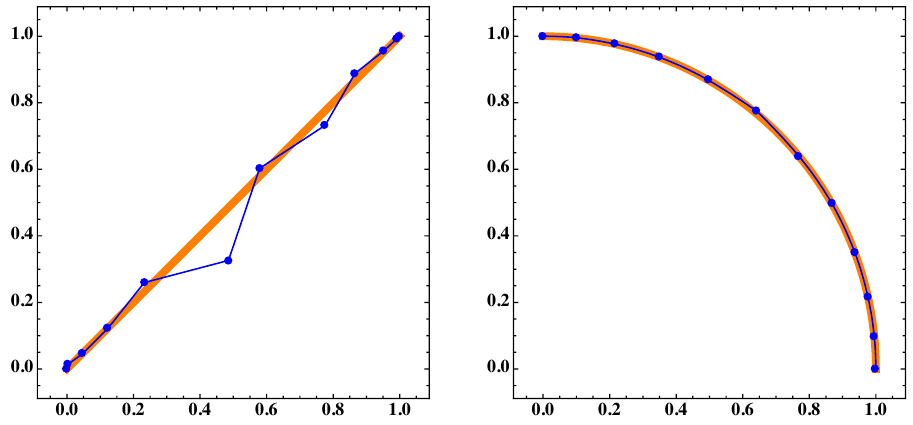
Figure 21. The same as in Figure 20 but for γ =